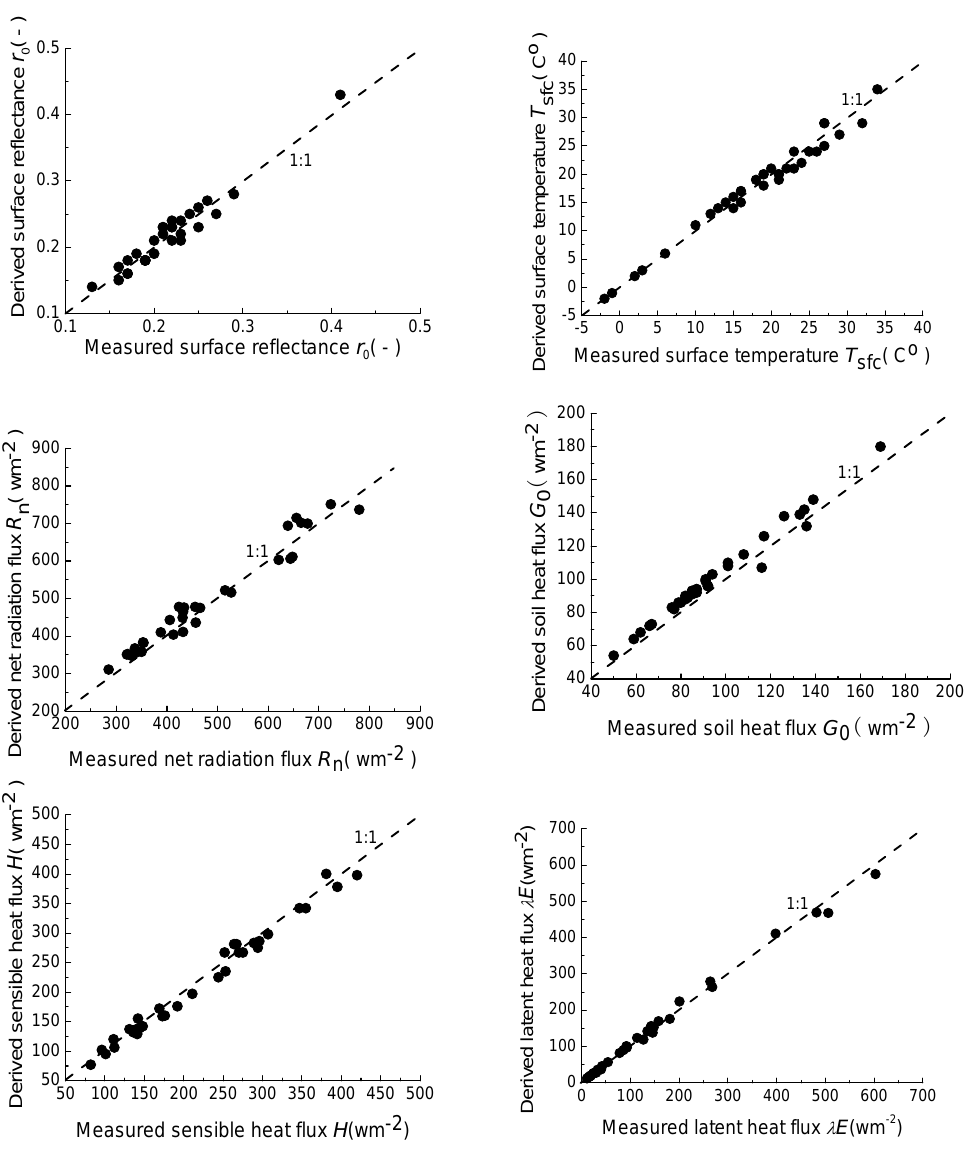
Fig. 5. Comparison of derived results with field measurements for the surface reflectance, surface temperature, net radiation flux, soil heat flux, sensible heat flux and latent heat flux over the Tibetan Plateau area, together with a 1:1 line.